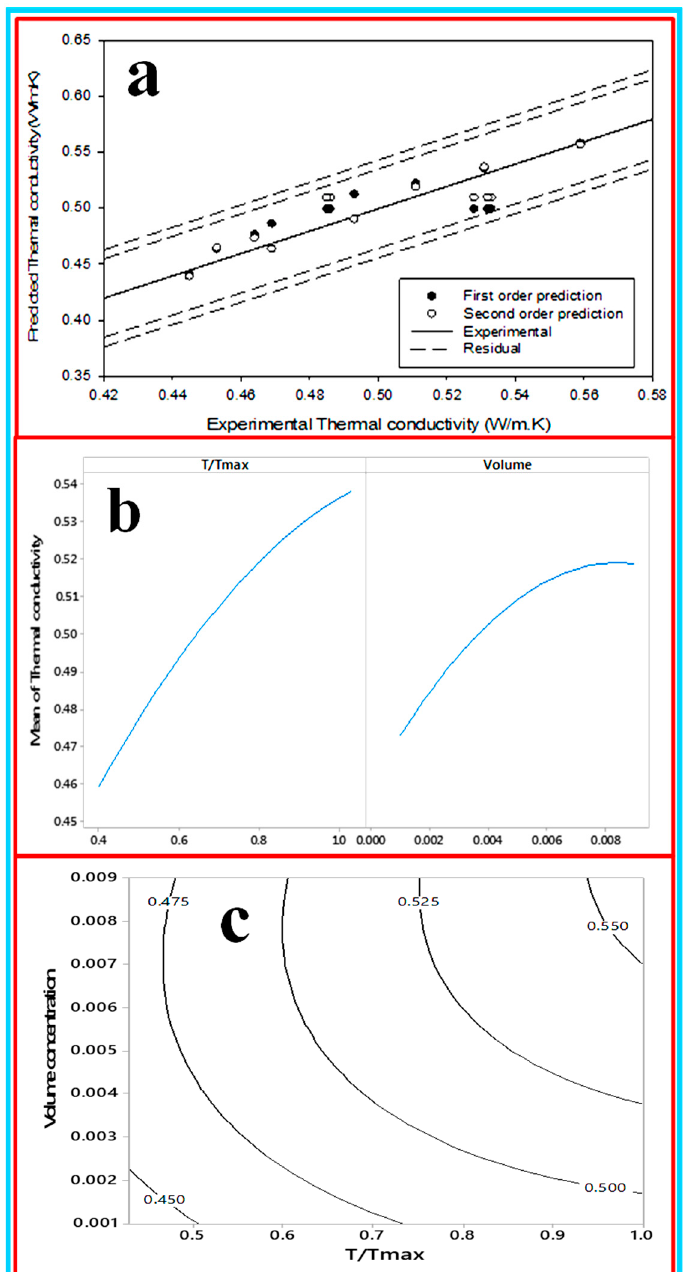
Figure 17. ( a ) Predicted thermal conductivity, ( b ) the factorial plot and ( c ) the contour plot for the thermal conductivity. thermal